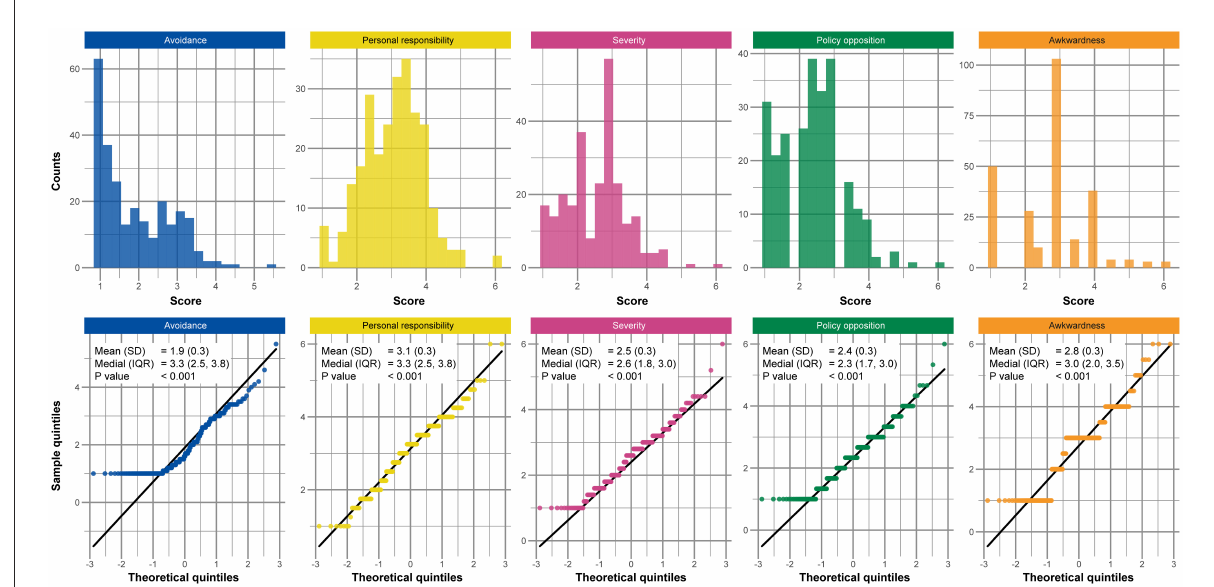
FIGURE1 Histograms and QQ-plots of the scores for each factor of social stigma related to COVID-19. Definitions of each factor are as follows: avoidance is an attitude of avoiding the patient; personal responsibility is to anticipate that the infected persons themselves are responsible for their infection; severity is to anticipate that you could not return to normal again once infected; policy opposition is to expect more public funding investment for patients’ care; awkwardness is an attitude of feeling uncomfortable being with a person who had the infection before. the p -values were calculated using the Shapiro-Wilk test. SD; standard deviation, IQR; inter-quartile range, QQ; quintile-quintile, COVID-19; coronavirus